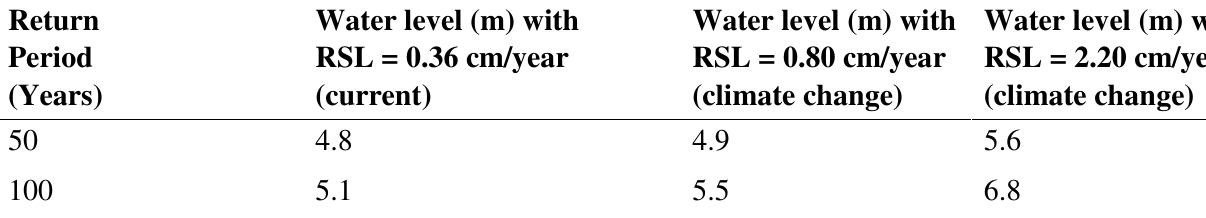
Table 2. Water levels (m) for return periods of the 50 and 100 year events with different sea-level rise projections (from [35,41,50]). The water level has been rounded to the nearest